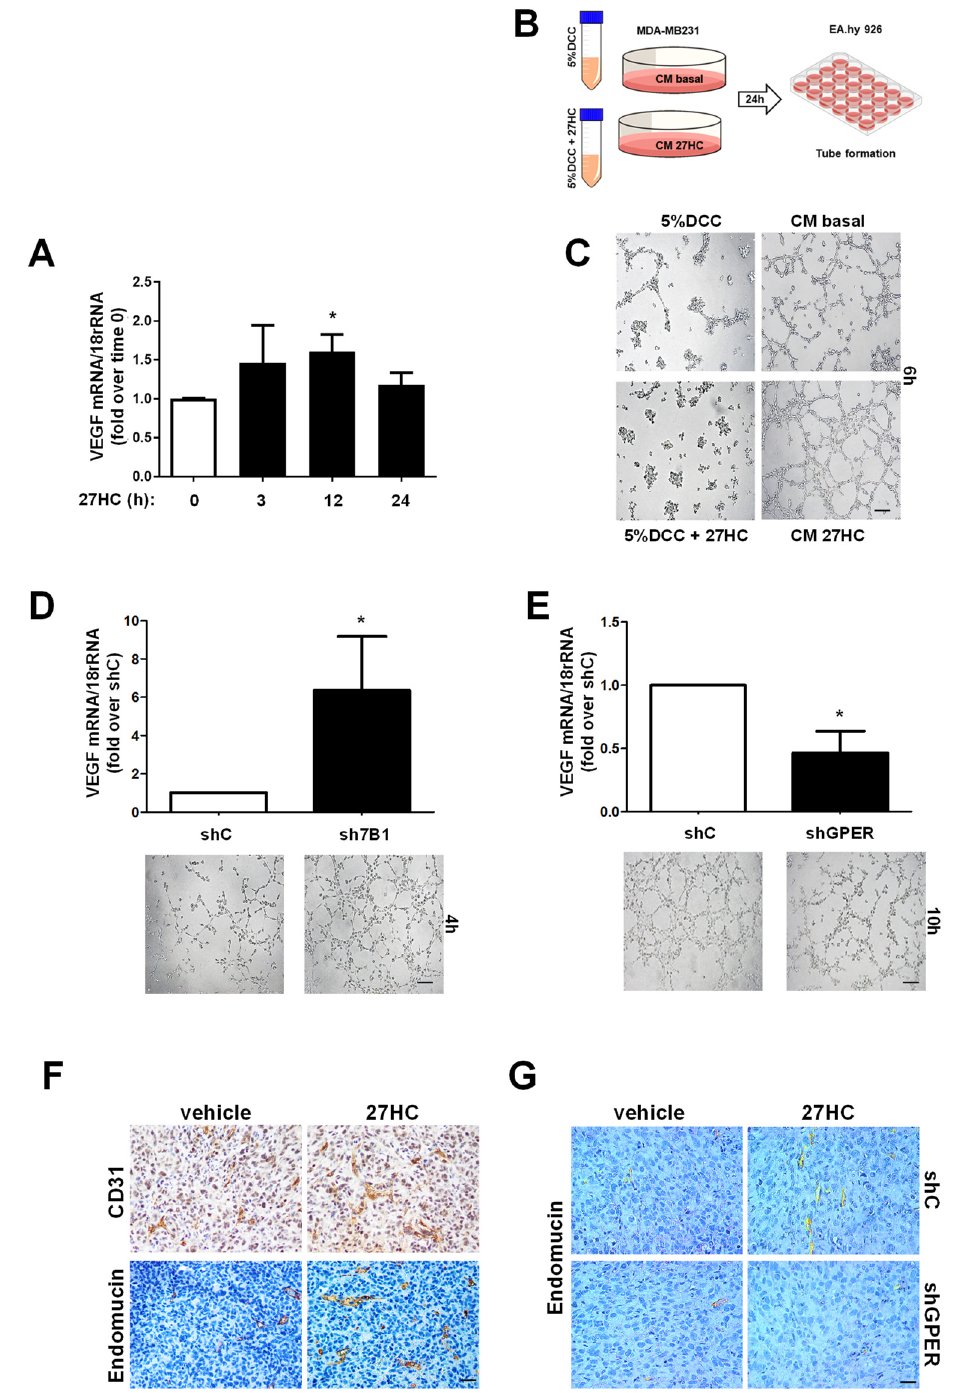
Figure 6. GPR30 is required to promote 27HC-induced angiogenesis in ER − BC cells. ( A ) . QPCR analysis of VEGF in MDA-MB-231 cells treated for the indicated times with 27HC (10 − 6 M) * p < 0.05 vs. basal (untreated) cells. ( B ) Graphical protocol used for the preparation of MDA-MB-231 conditioned medium (CM). ( C – E ) Tube formation in EA.hy926 exposed to conditioned media collected from MDA-MB-231 without (basal) and with 27HC (10 − 6 M) ( C ) and from shC, sh7B1 ( D ) and shGPER ( E ) * p < 0.05 vs. shC cells. Images were obtained with a 10X objective, scale bar 50 μ m. ( F ). Abundance of CD31 and endomucin was evaluated by immunostaining in xenografts tumors of parental ( F ) or shC and shGPER ( F ) MDA-MB-231 cells. Images were obtained with a 20X objective, scale bar 25 μ m.